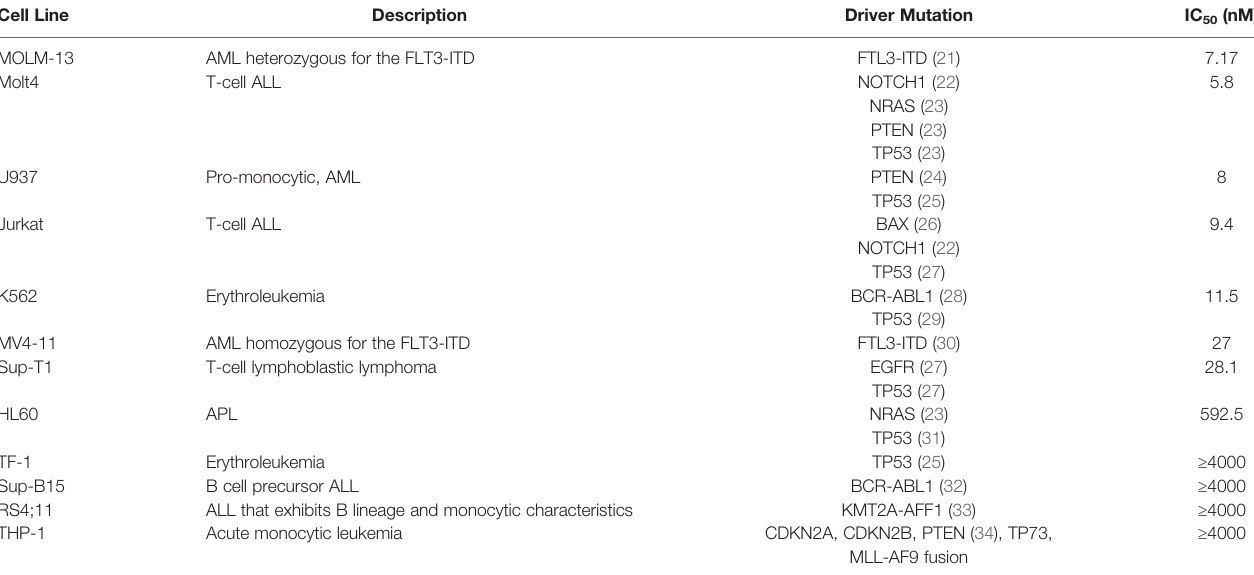
TABLE 2 | Sensitivity of leukemia cell line proliferation to emvododstat.